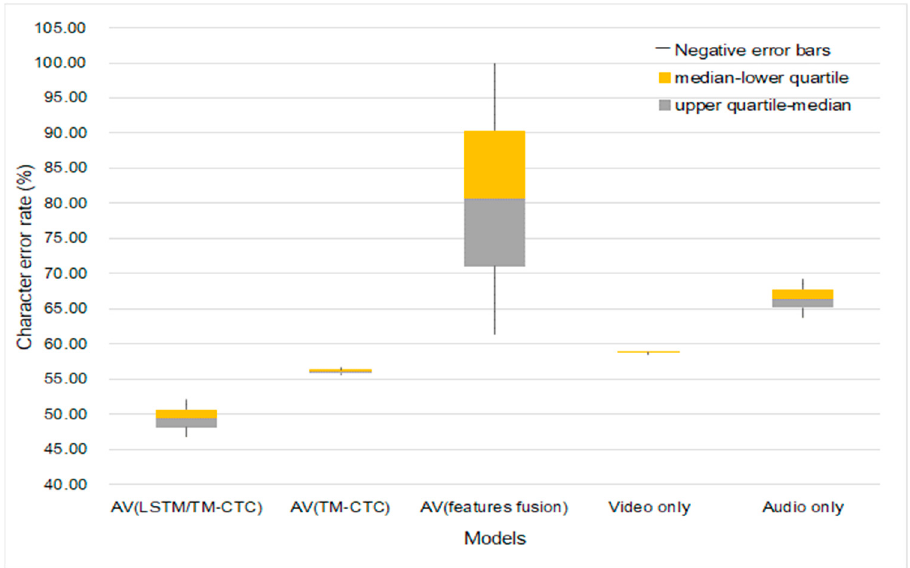
Figure 7. Models’ generalization onto different speakers.